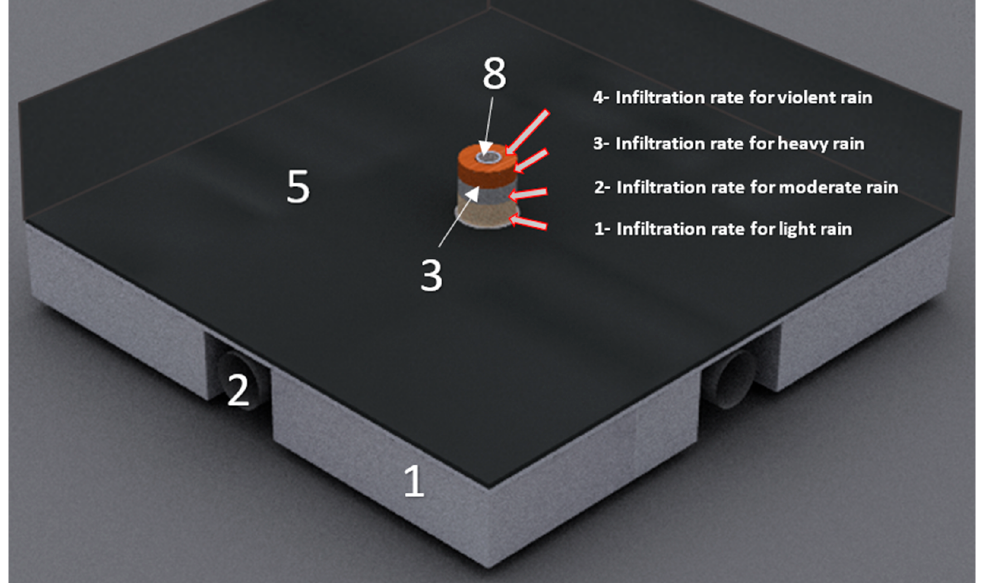
Figure 13. Waterproofing membrane layer and details of the multilayer filter. Note: the total height after this layer needs to be equal to the entrance level of the filters so that the filters can drain the water and will not remain on the surface of this layer. (1) Polystyrene foam or other low-weight materials (the same diameter of PVC pipe); (2) PVC (75 mm, 90 mm, 100 mm, or 110 mm); (3) multilayer filter (the same diameter as the pipe and the exact height of the total green roof dimension); (5) waterproofing membrane; (8) drain filters.